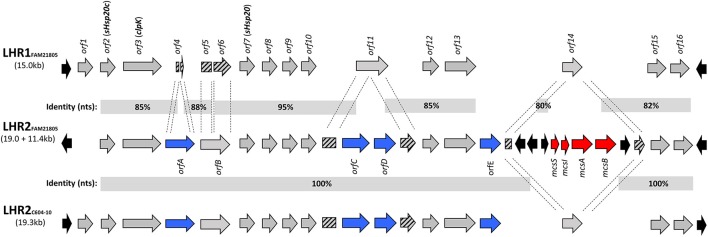
Comparison of loci of heat resistance in FAM21805 (LHR1 and -2) and C604-10 (LHR2). ORFs present in all three LHRs are marked in gray (except for orf1 which is absent in LHR2FAM21805), ORFs unique to LHR2 are marked in blue, partially disrupted ORFs are marked with stripes, and mobile elements are marked in black. Regional nucleotide identities (%) are depicted. A 11.4 kb region containing the mcsSIAB cluster (Microcin S system, marked in red) has been inserted into LHR2FAM21805. For additional information on the ORFs, see Supplementary Table 1.